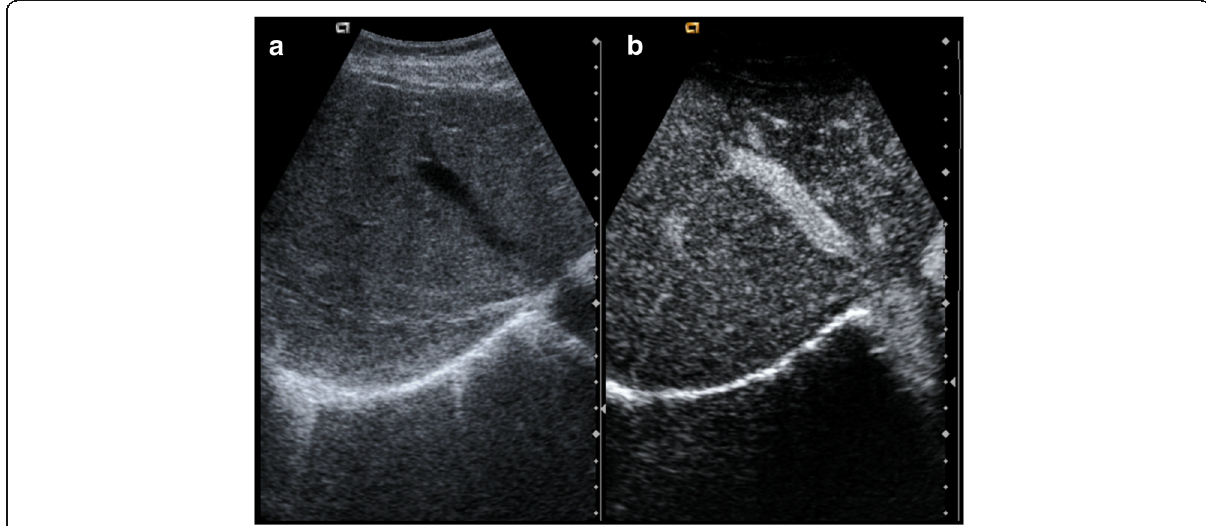
Fig. 14 a , b Thrombosis of the right hepatic vein. The right suprahepatic vein is more echogenic than the middle hepatic vein. After contrast administration, there is an enhancement of the middle hepatic vein, showing normal flow. The right hepatic vein does not enhance because of